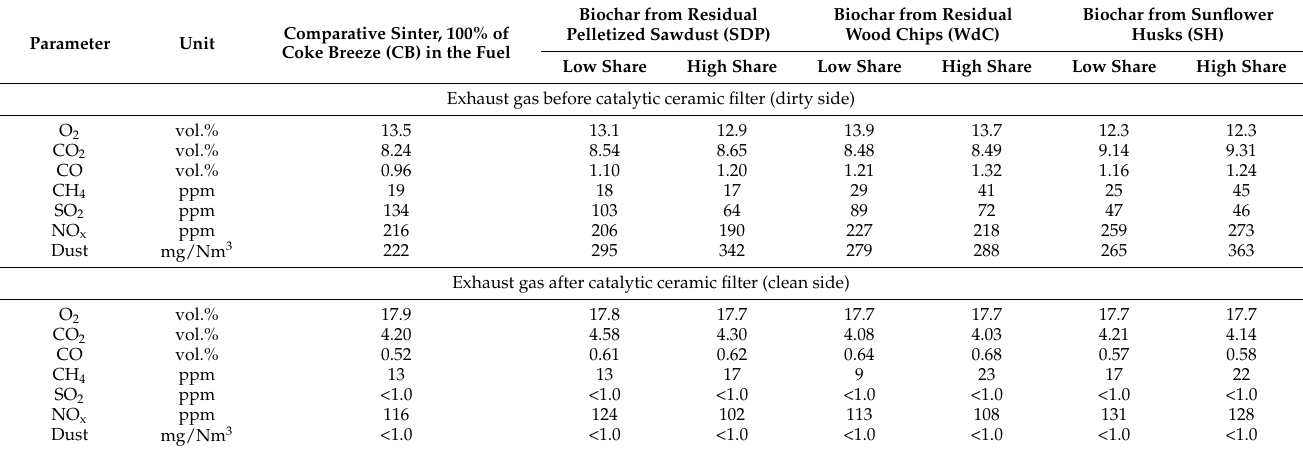
Table 7. * The average composition of exhaust gas on the dirty side (before catalytic ceramic filter) and on the clean side (in the emitter) obtained for fuel mixtures with biochar and coke breeze only. Parameter